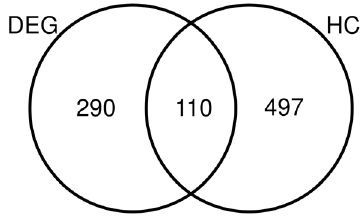
Figure 2. Number of fibrosis-relevant genes from differential and co-expression analysis. Number of genes in the liver fibrosis- relevant differentially expressed gene list and liver fibrosis-relevant co- expressed gene list and the overlap between them.